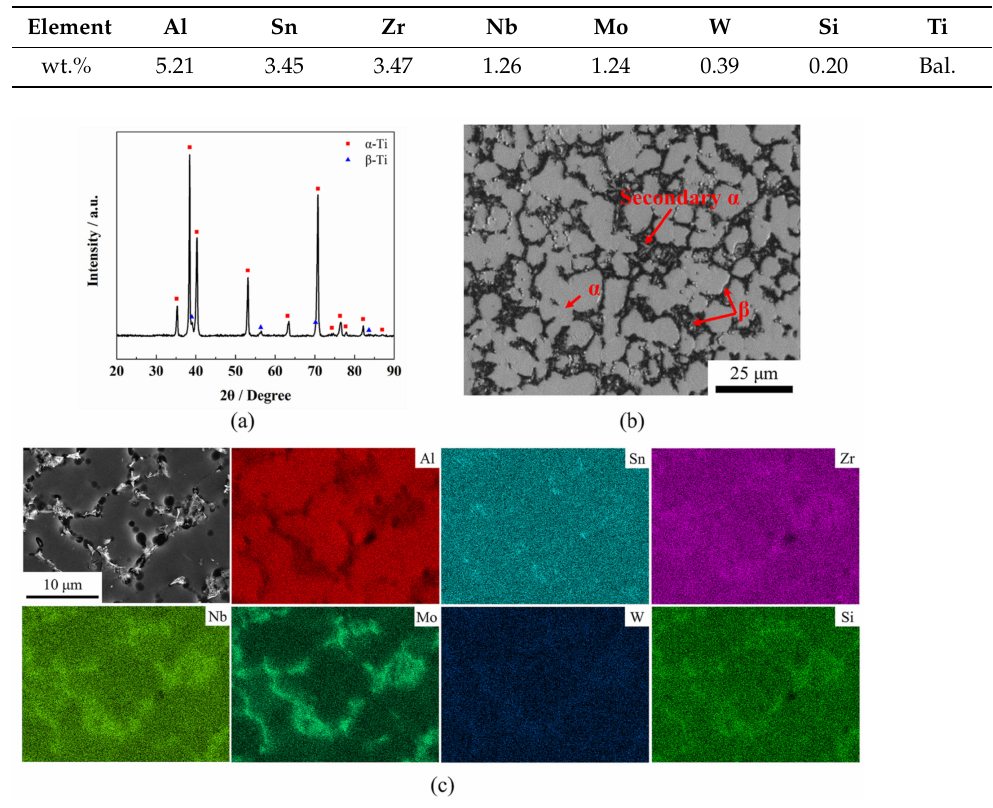
Figure 1. ( a ) The XRD of the TC31 titanium alloy; ( b ) microstructure of the as-received sheet; ( c ) the EDX elemental mapping of the TC31 titanium